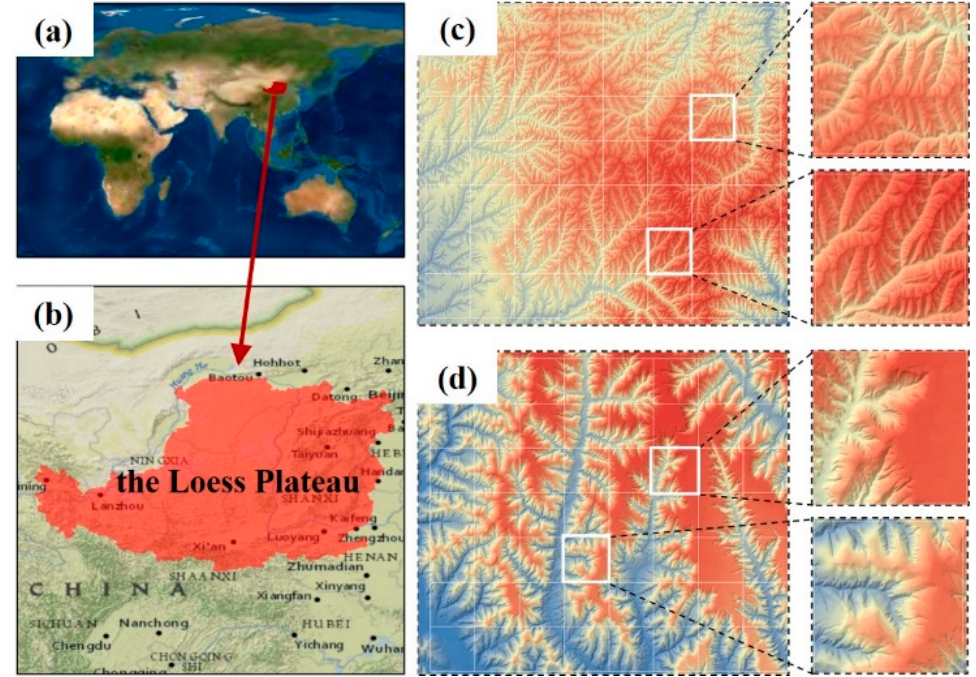
Figure 1. Example of sample data. ( a,b ) the location of the Loess Plateau; ( c,d ) the terrain in the Loess Plateau (the size of a small patch is 256 × 256 pixels).